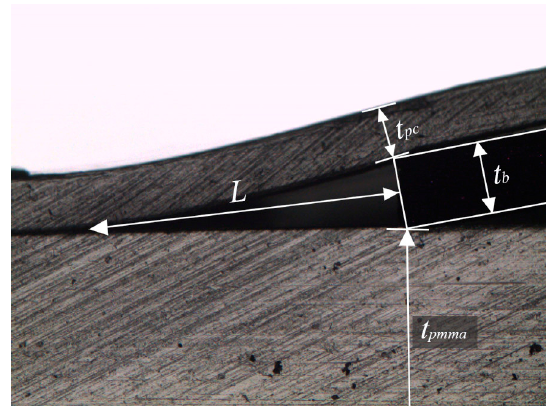
Figure 6. Crack opening method for measuring the bonding strength.